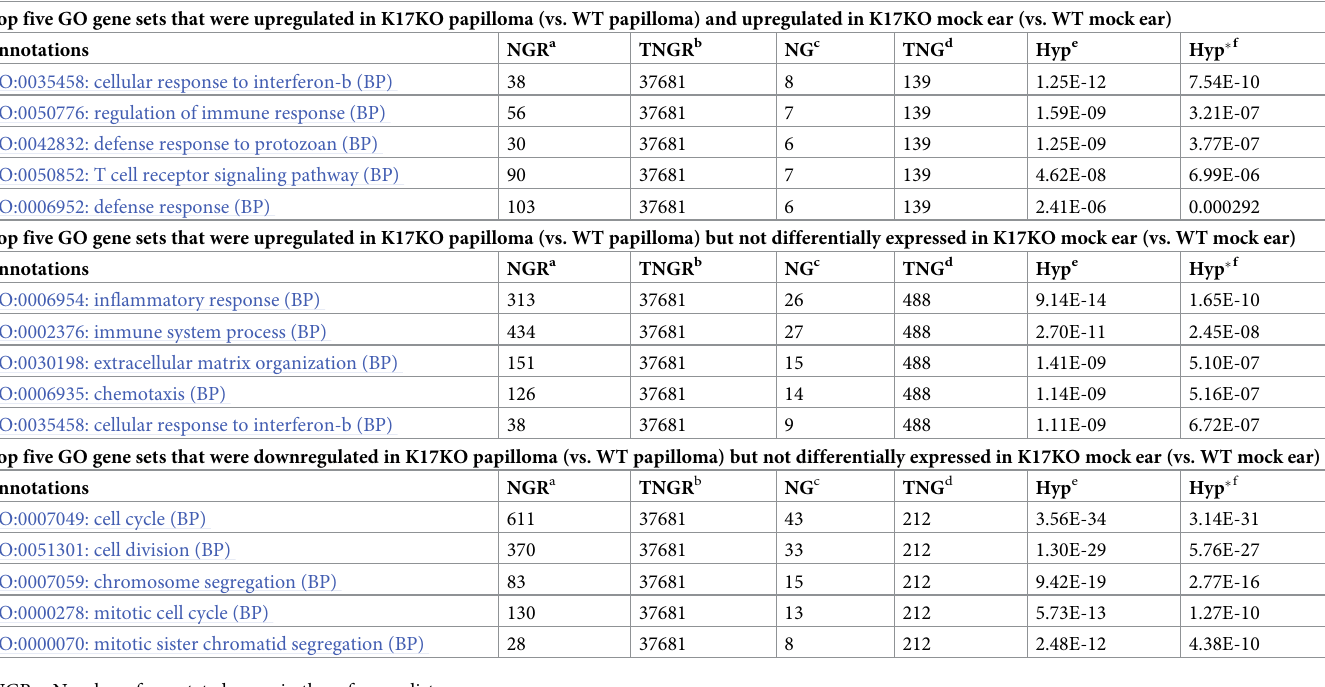
Table 1. Gene Ontology analysis of differentially expressed genes in K17KO papilloma vs. WT papilloma. Top five GO gene sets that were upregulated in K17KO papilloma (vs. WT papilloma) and upregulated in K17KO mock ear (vs. WT mock ear) Annotations